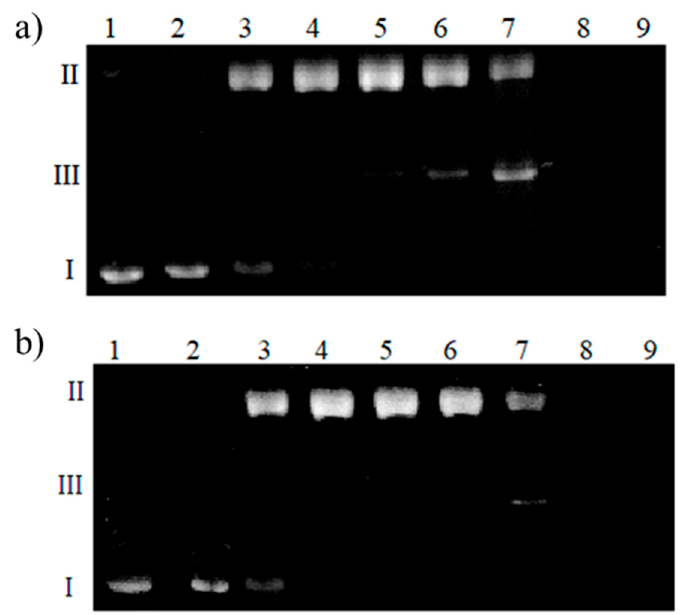
Figure 9. Plasmid DNA degradation in the presence of ( a ) Cu(II)-L 1 and ( b ) Cu(II)-L 2 complexes with different concentrations of ascorbic acid. Lane 1: plasmid; lane 2: plasmid + 50 µM complex; lane 3: plasmid + 50 µM complex + 5 µM Asc; lane 4: plasmid + 50 µM complex + 10 µM Asc; lane 5: plasmid + 50 µM complex + 25 µM Asc; lane 6: plasmid + 50 µM complex + 50 µM Asc; lane 7: plasmid + 50 µM complex + 100 µM Asc; lane 8: plasmid + 50 µM complex + 250 µM Asc; lane 9: plasmid + 50 µM complex + 500 µM Asc.